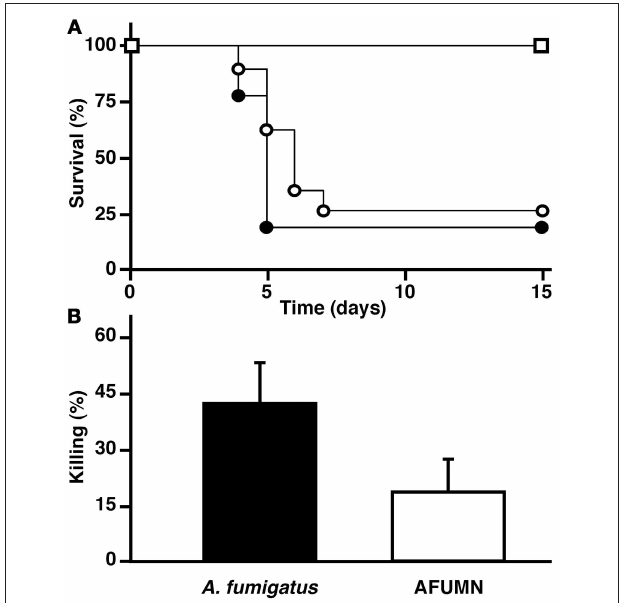
FIGURE 4 | A. fumigatus var. niveus kills neutropenic mice and survives macrophage phagocytosis just like A. fumigatus Af293. (A) Comparison of A. fumigatus var. niveus (open circles) and A. fumigatus Af293 (closed circles) survival in a neutropenic murine model of pulmonary aspergillosis. BALB/c neutropenic mice were inoculated through intranasal instillation with of 5.0 × 10 4 conidia and body-weight measured every 24h and after reaching a 20% reduction, mice were sacrificed and statistical significance of comparative survival values calculated using log rank analysis and the PRISM statistical analysis package. (B) Conidial killing by murine alveolar macrophages assay. To evaluate conidial killing by murine alveolar macrophages, phagocytic cells were harvested and incubated with A. fumigatus var. niveus or A. fumigatus Af293 conidia (5 conidia per macrophage) and surviving conidia determined through CFU counting during serial